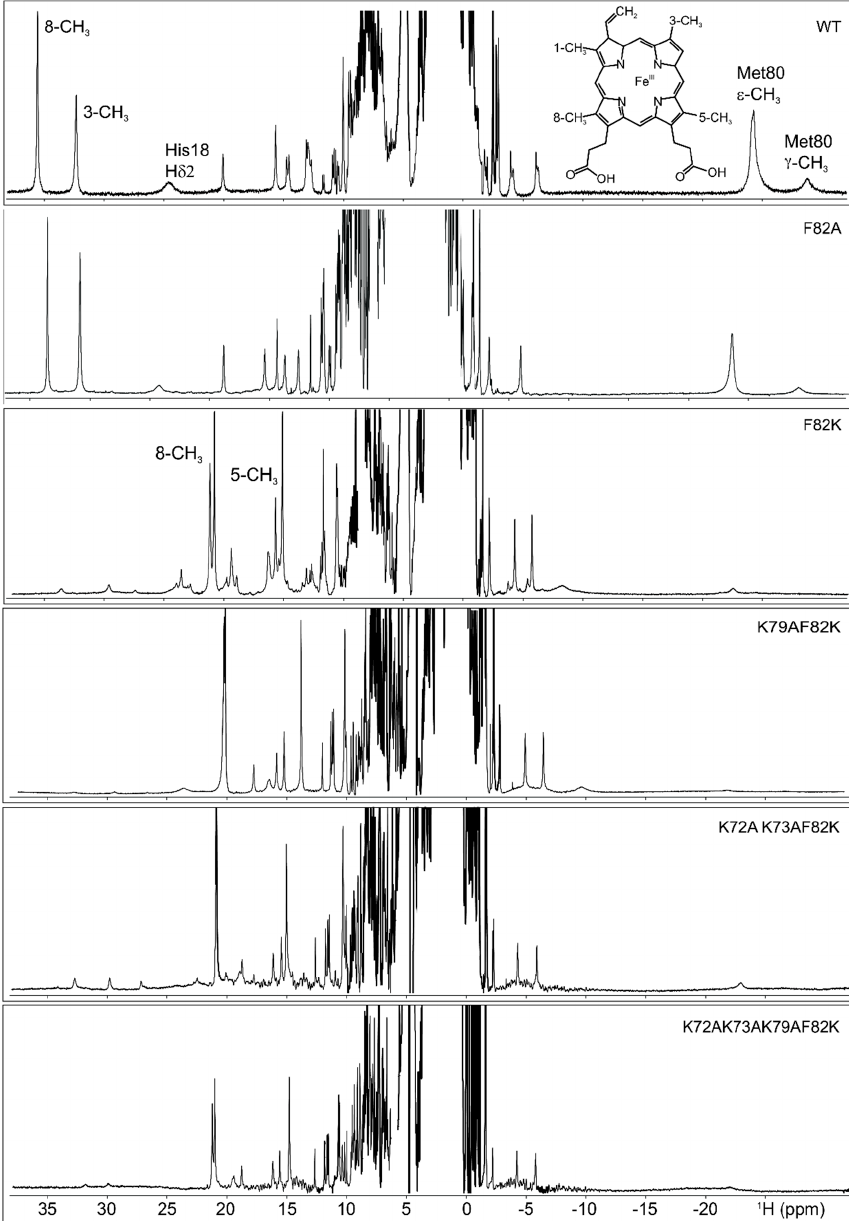
Figure 2. Comparison of the hyperfine shifted resonances in the 1 H NMR spectra of the ferric form of the wild-type human cyt c and of its variants: F82A, F82K, K79AF82K, K72AK73AF82K, and K72AK73AK79AF82K. Spectra were acquired at 700 MHz and 298 K in 20 mM phosphate buffer, pH 6.8. The resolved heme methyl, His18 and Met80 signals for the wild type protein, and the 8-CH 3 and 5-CH 3 methyls for the F82K were provided. The structure of the heme prosthetic group of cyt c, where the methyl groups were numbered according to the Fischer nomenclature, is added as an inset.